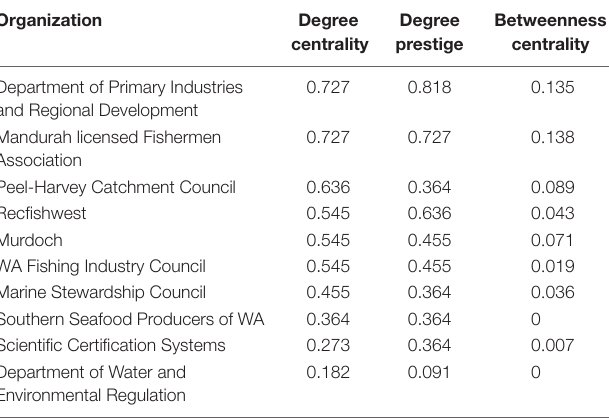
TABLE 6 | Results showing centrality and prestige measures for organizations represented in the closed population network, ( n = 35). Organization Degree